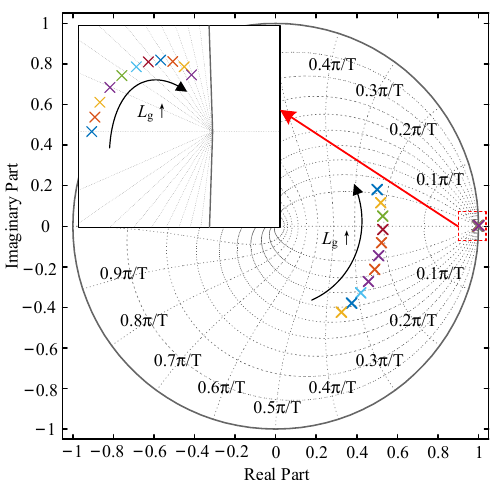
Figure 7. Closed-loop pole diagrams of the system under various grid impedances.